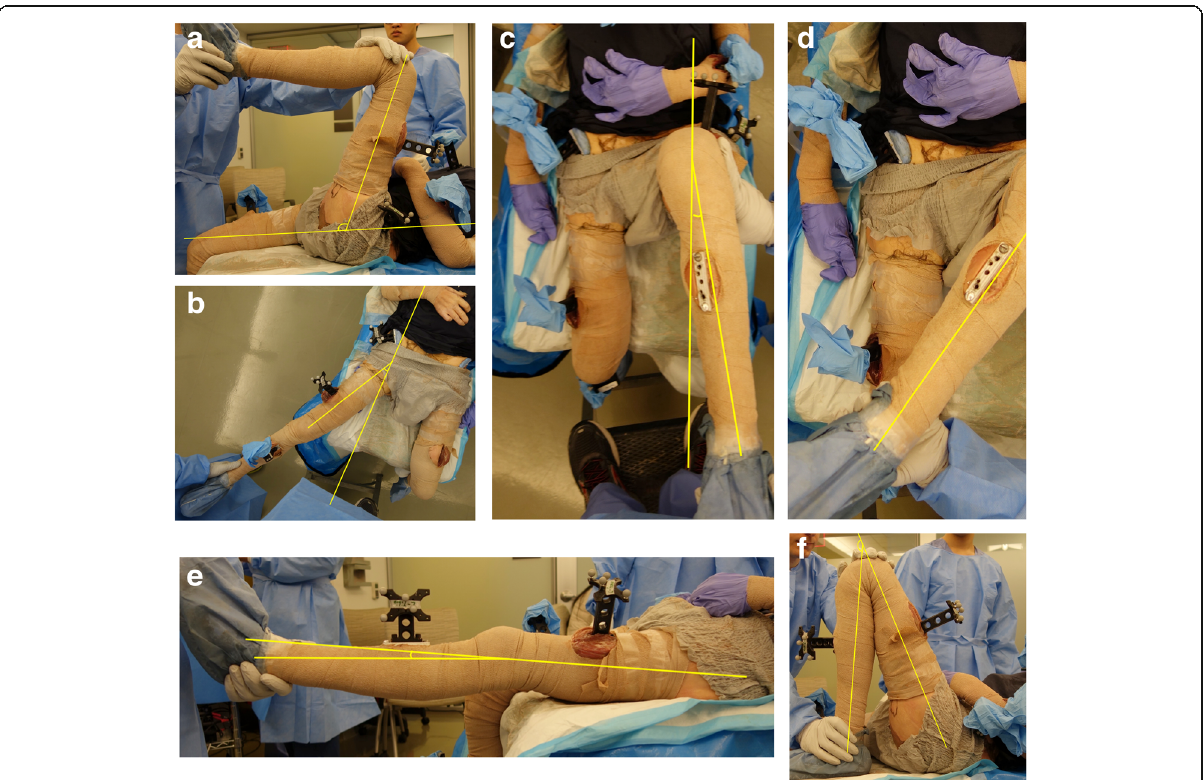
Fig. 3 Examples of the investigator ’ s view during visual estimation, photographing of the limb position (for subsequent angle measurement), and goniometric measurement. All measured positions are shown, including: a hip flexion, b hip abduction, c hip internal rotation, d hip external rotation, e knee extension, and f knee flexion. A stepladder was used when necessary to obtain a “ bird ’ s eye ” view of the joint (i.e. hip abduction, internal rotation, and external